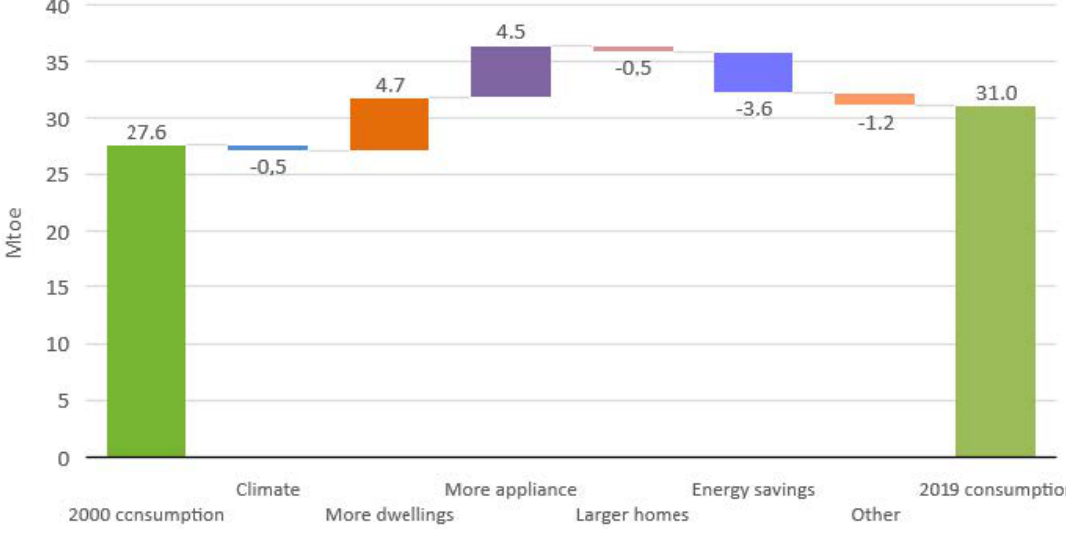
Figure 2. Variation in household consumption in Italy — Mtoe (2000 – 2016) [26].